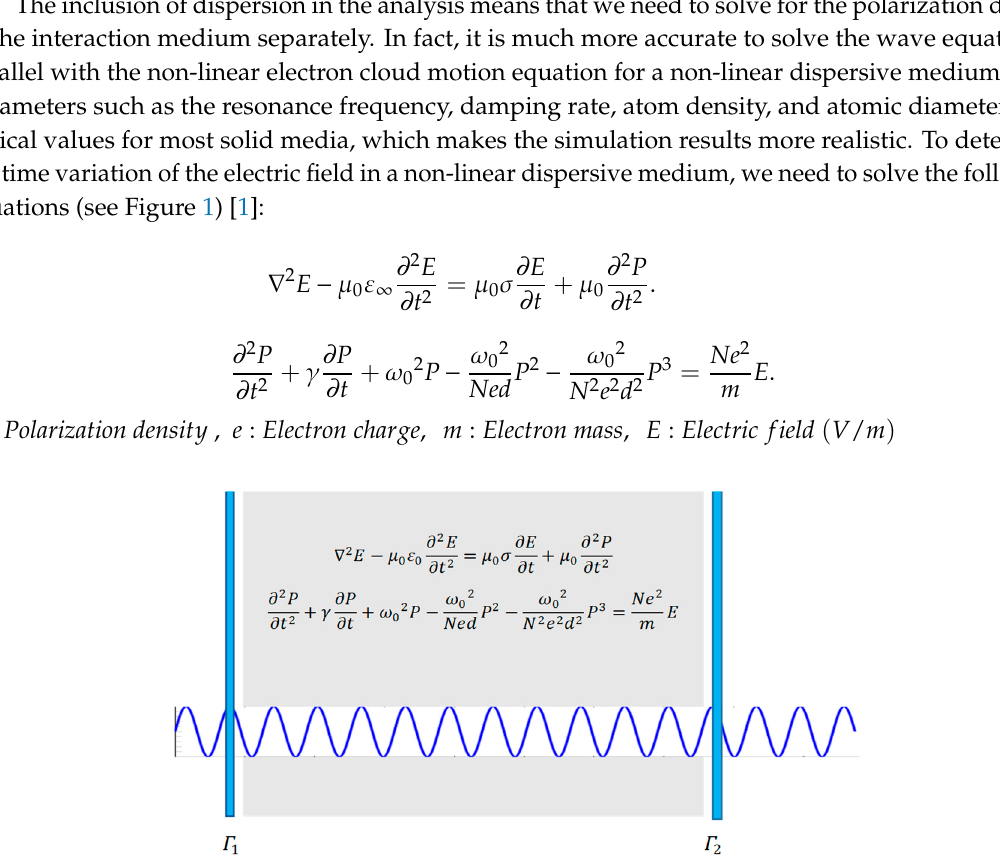
Figure 1. An interaction medium placed inside a cavity.